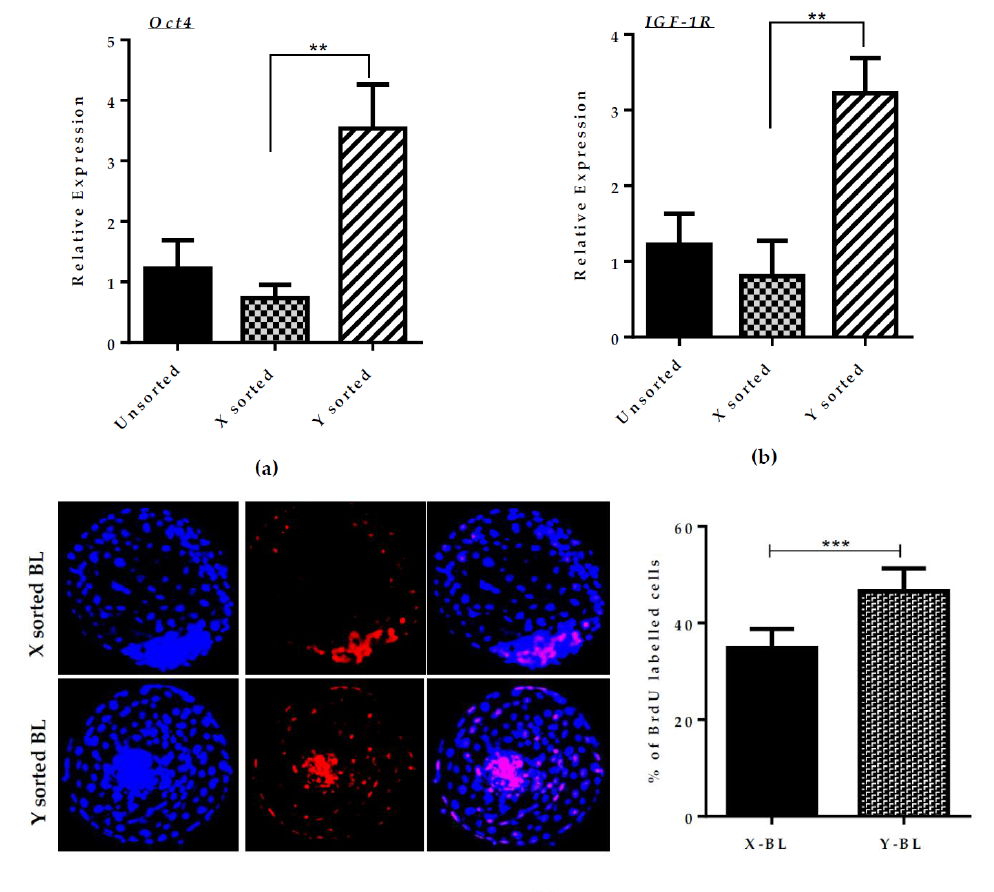
Figure 1. Di ff erences in developmental competence and cell proliferation ratio during X- and Y-BL (blastocyst) development. Relative mRNA expression of ( a ) OCT4 and ( b ) IGF1-R in unsorted, X-sorted, and Y sperm-sorted day seven BLs. ( c ) Immunofluorescence staining of 5-bromo-2 (cid:48) -deoxyuridine (BrdU) in X and Y sperm-derived day seven BL. Quantification of cell proliferation rate. Bar graph data represent means ± SEM (standard error of mean) from three independent sets of experiment, including n = 20 BLs per group in each replicate. ** p < 0.01 ; *** p < 0.001 indicates significant di ff erence. Original magnification 100 ×